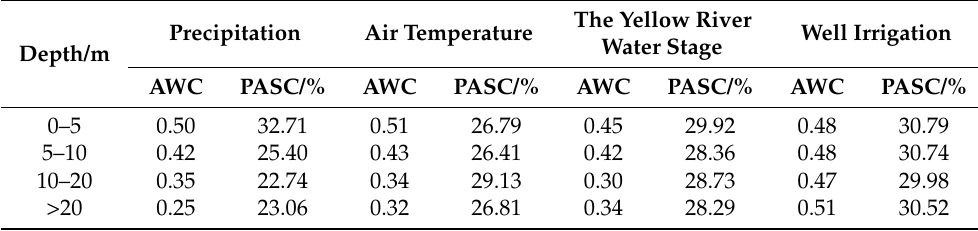
Table 4. Arithmetical means of average wavelet coherence (AWC) and percentage area of significant coherence (PASC) between the groundwater level and the four factors for different groundwater buried depths.